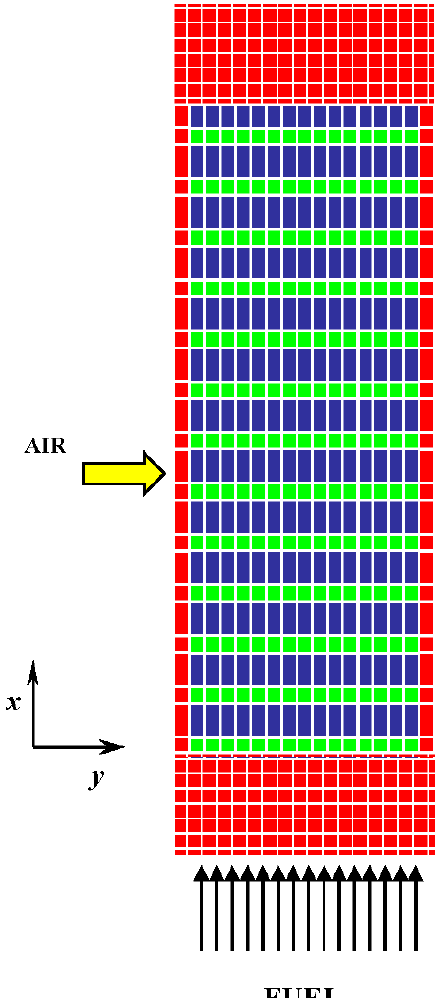
Figure 3. Discretization mesh for model integration.